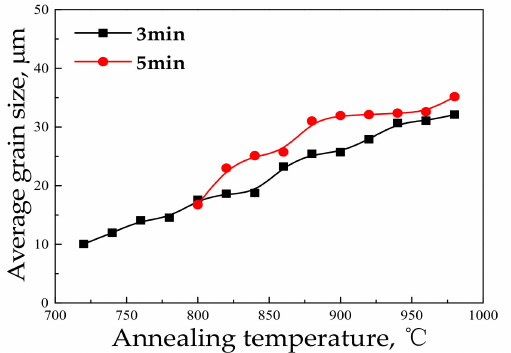
Figure 3. Change trend of grain sizes (TD samples) with annealing temperature of Fe-0.65%Si non-oriented electrical